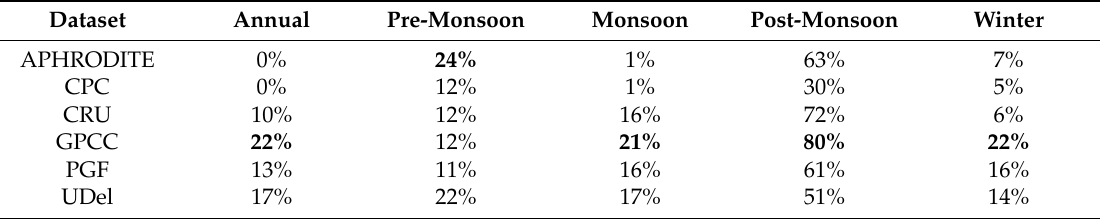
Table 4. The Jaccard similarity coefficient calculated for annual and seasonal rainfall changes estimated for the period 1979–2010. The highest values for different seasons are presented using bold font.